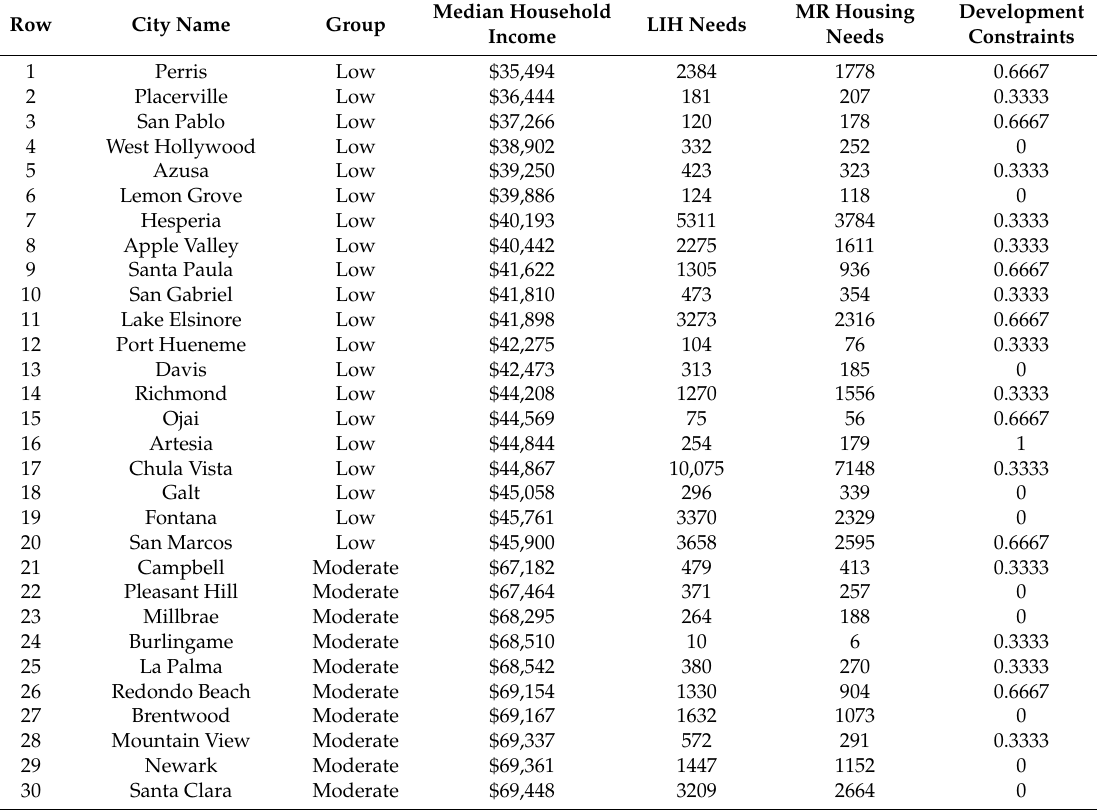
Table 1. Sample ranked by year 2000 median household income. California’s 2000 Median